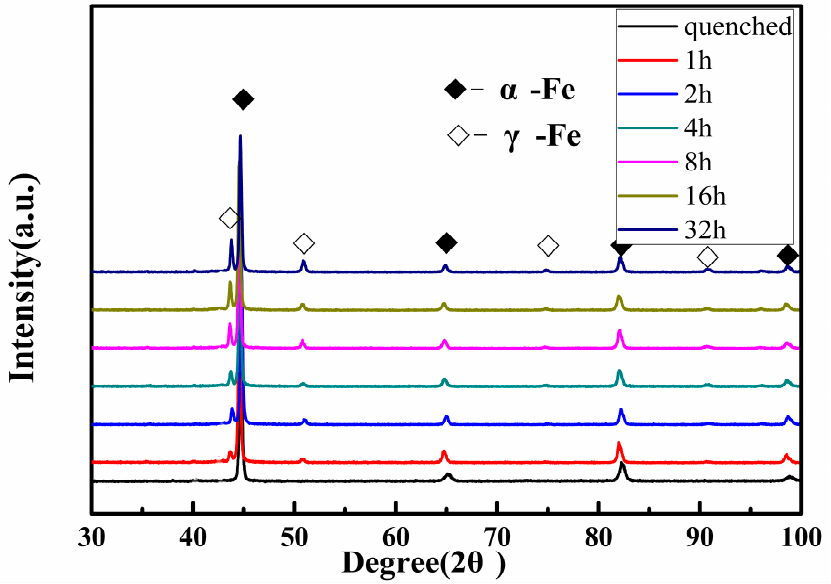
Figure 2. XRD pattern of the samples quenched and tempered at 620 °C for different tempering times.